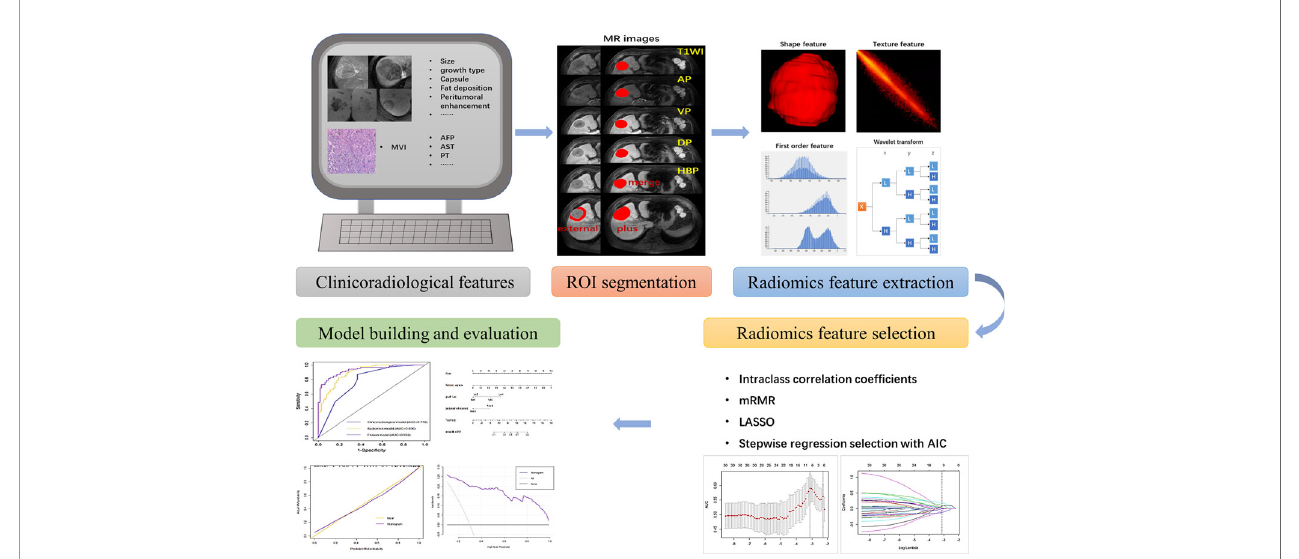
FIGURE 1 | A fl owchart showing the radiomics analysis for MVI prediction. The clinicoradiological characteristics (especially the status of MVI) were identi fi ed fi rst. ROI segmentation was performed on axial LAVA MR images, and then radiomic features were extracted, including shape features, fi rst-order features, textural features, and wavelet transformed features. Next, features with high stability (ICC > 0.8) were included and further selected via mRMR, LASSO and stepwise regression analysis with AIC. The MVI prediction model was constructed by incorporating the radiomics signature and clinicoradiological risk factors. A nomogram was adopted to present the model and evaluated with calibration curve and decision curve